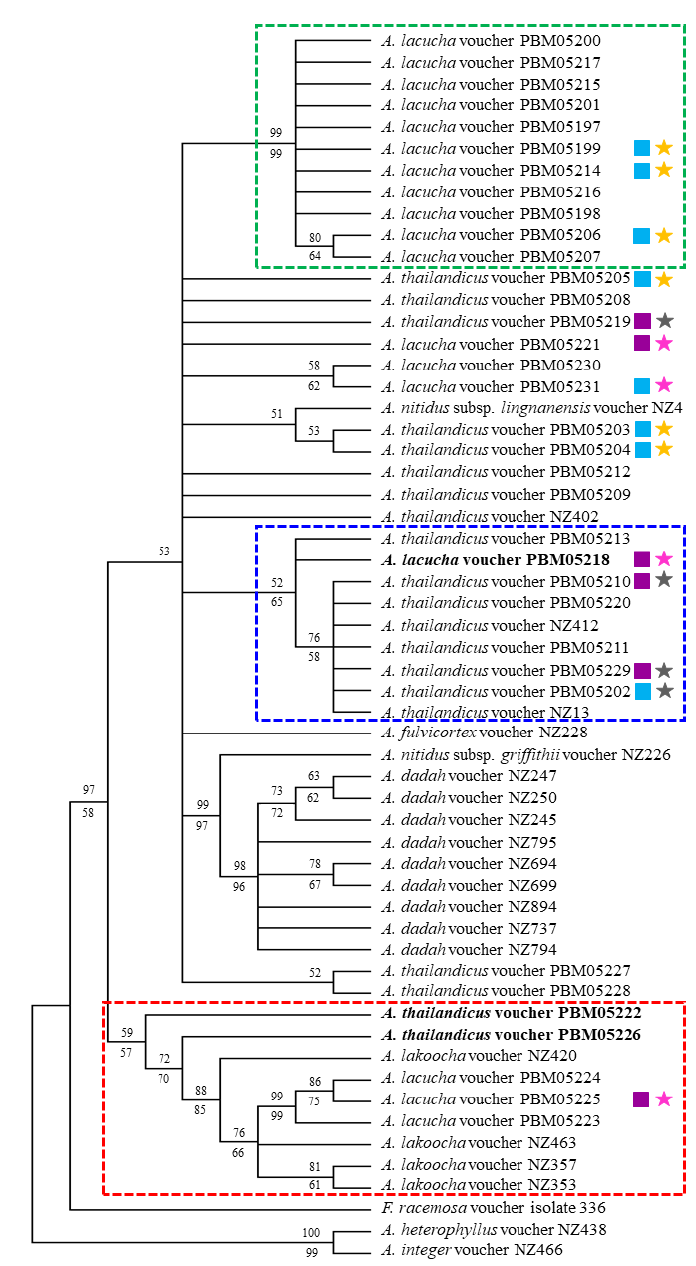
Figure 5. Maximum parsimony (MP) and maximum likelihood (ML) analysis of A. lacucha and A. thailandicus with other Artocarpus species. A. integer and A. heterophyllus were chosen as outgroup. The bootstrap percentage of MP and ML were shown as above and below the branches, respectively. Two minor clades, the blue and red square dashed line, indicated that both species were clustered together in the same clade with low bootstrap support. Some parts of the trees showed unresolved topology. Some samples of A. lacucha formed only one well-supported clade with 99% bootstrap support (indicated by green square dashed line). The SEM results were correlated. Light-blue square: upper surface glabrous; purple square: upper surface with straight and uncinate smooth hair; yellow star: lower surface with gnarled papillae on the veinlets, sparsely smooth straight or uncinate hairs on lateral veins; pink star: lower surface with gnarled long straight hairs mostly on veinlets; grey star: lower surface with gnarled long straight hairs mostly on the veinlets with tomentose hair in the areoles and densely smooth straight or uncinate hairs on the lateral